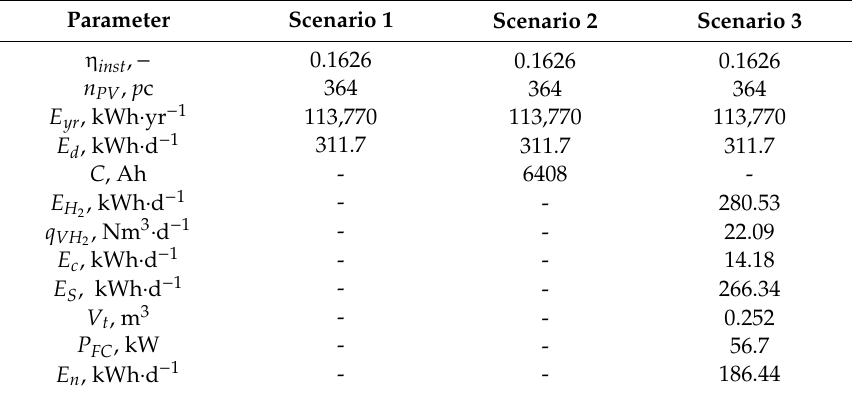
Table 3. Calculated parameters of the